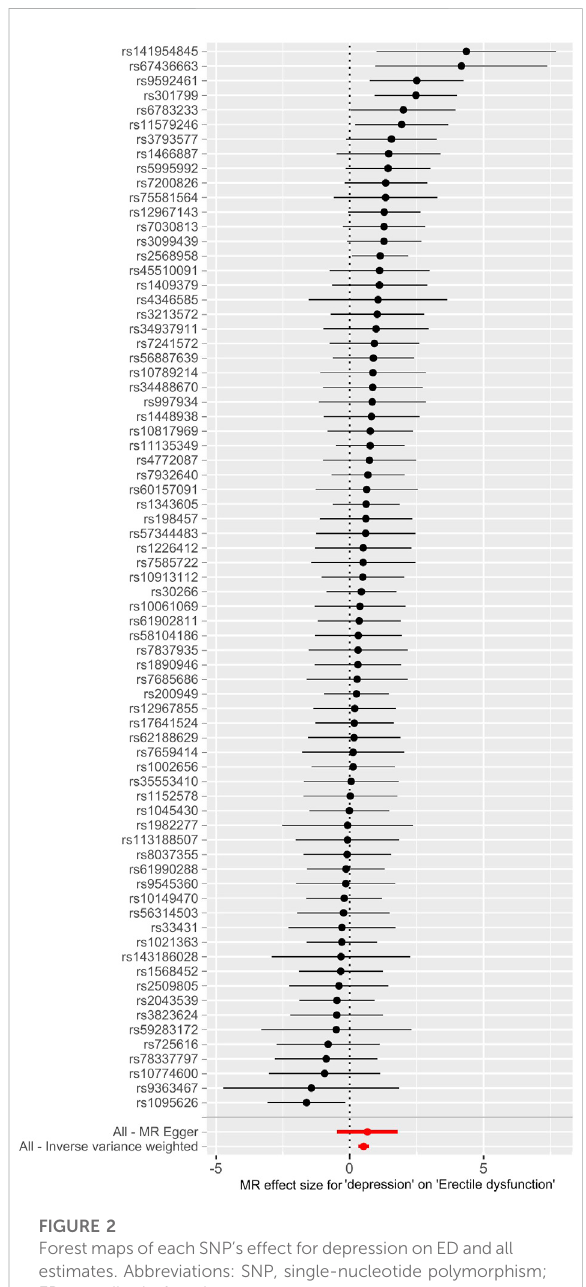
FIGURE 2 Forest mapsofeach SNP ’ seffect for depression onED andall estimates. Abbreviations: SNP, single-nucleotide polymorphism; ED, erectile